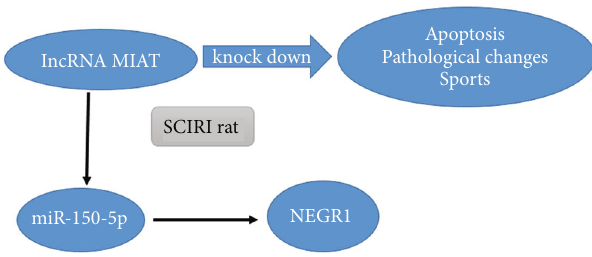
Figure 7: Summary of the results of the